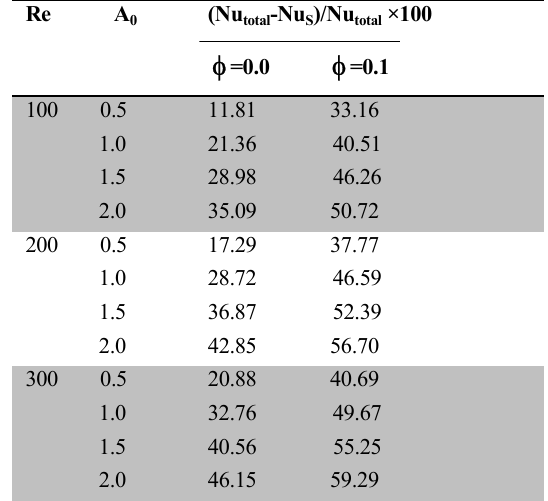
Table 3. Values of heat transfer enhancement at the rectangular channel using pulsating flow of alumina-water nanofluid at different